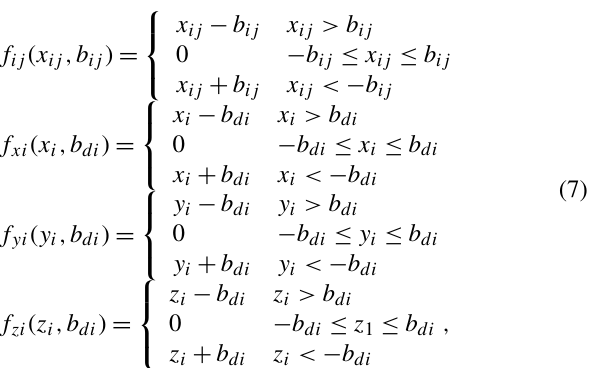
is the relative sliding speed, and sgn ( v s ) is the symbol